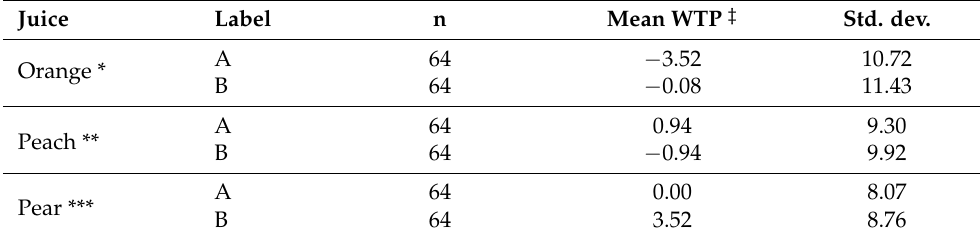
Table A4. Mean WTPs for the tasted juices. Juice Label n Mean WTP ‡ Std.